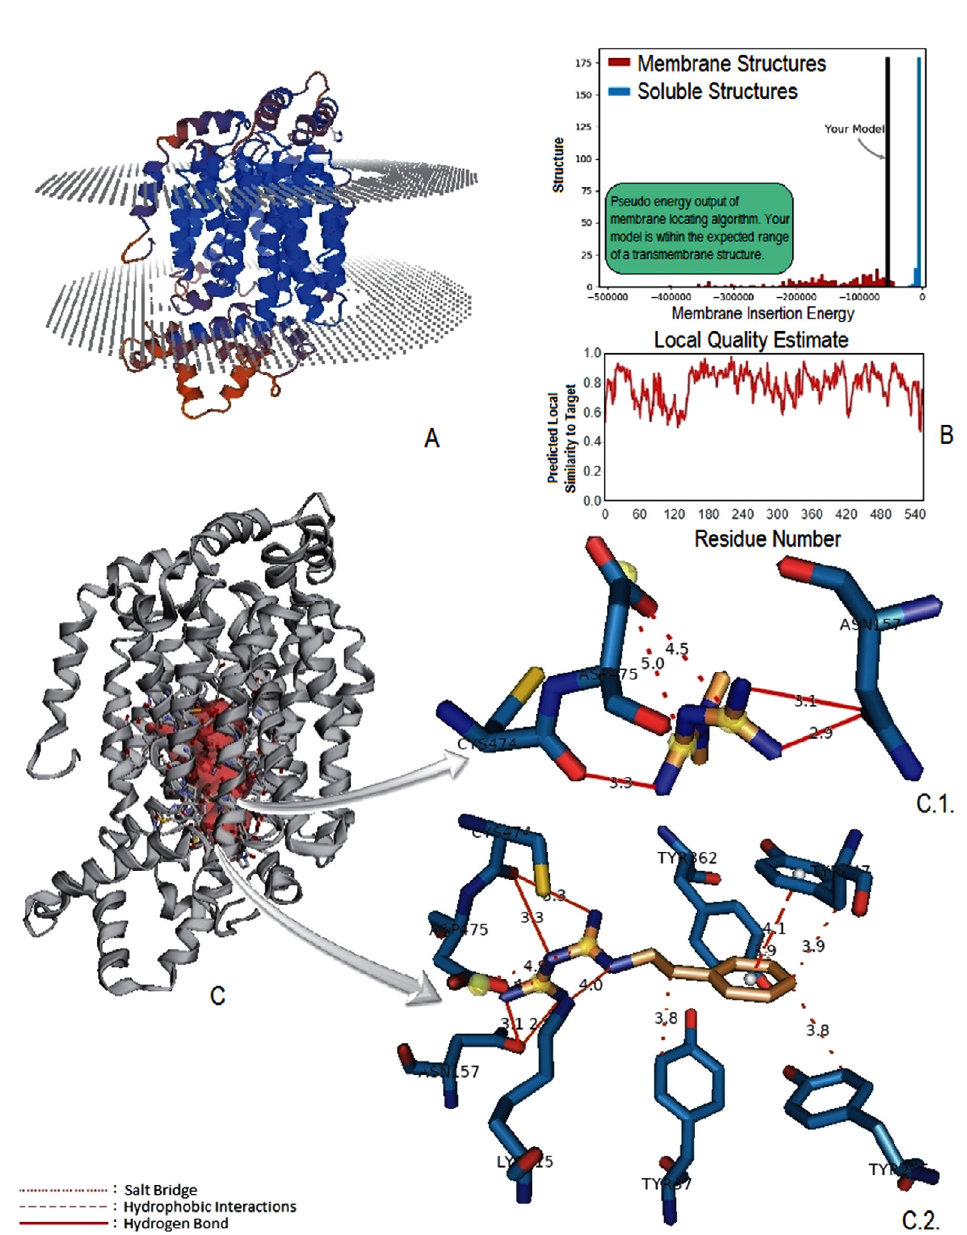
Figure 4. Representation of molecular modeling of OCT-2 and metformin, and phenformin. A. OCT-2 transmembrane protein embedded in the plasma membrane model was predicted by QMEANBrane. B. Structure validation of modeled OCT-1 concerning membrane insertion energy and the local quality estimate of the residues of the model OCT-2. C. The surface of the binding pocket of the model OCT-2 as computed using CASTp 3.0. Molecular simulation of the best pose of the interaction of OCT-2 and metformin(C1), phenformin(C2) with the highest docking